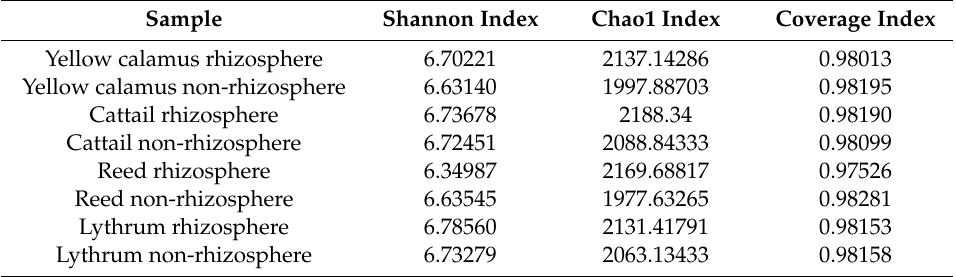
Table 4. Alpha diversity analysis of rhizosphere and non-rhizosphere soil of four aquatic plants.